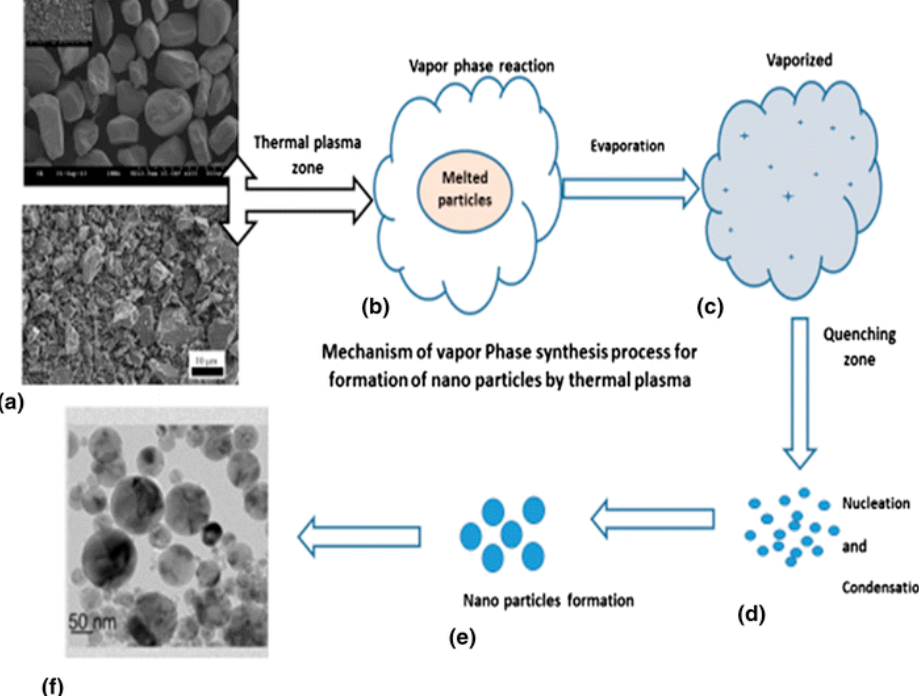
Figure 15. Vapor phase reduction synthesis of ilmenite particles toward titanium dioxide nanoparticles by thermal plasma process. Reprinted from [6] with permission of Springer 2018.